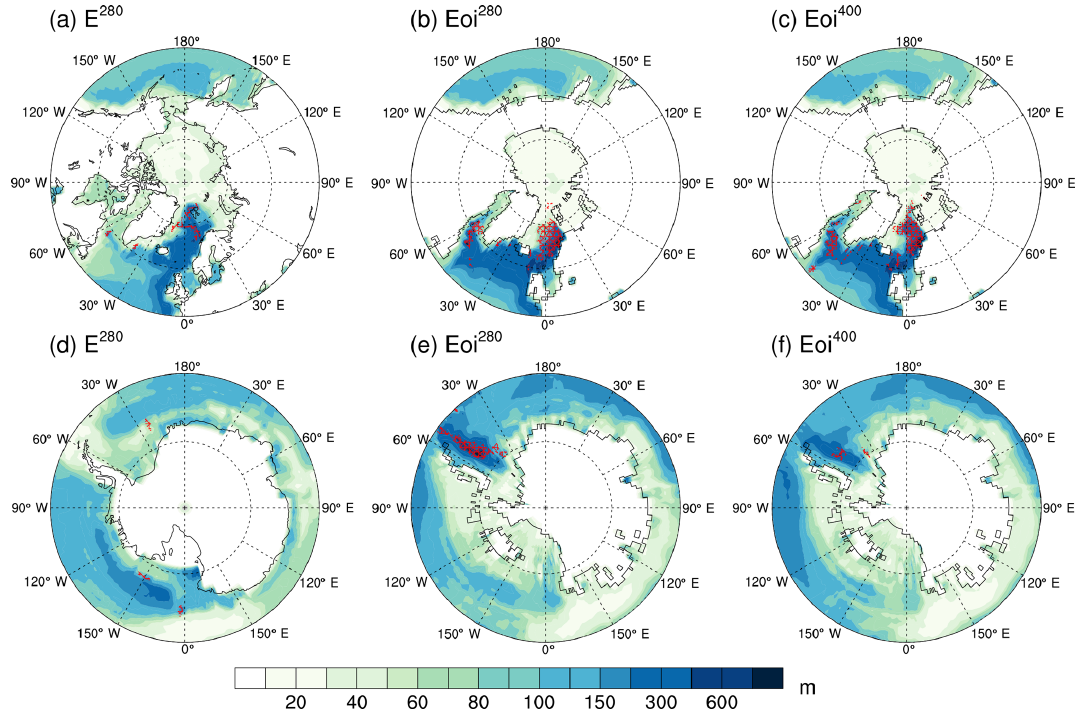
Figure 11. Mean March Northern Hemisphere and September Southern Hemisphere mixed layer depth for (a, d) E 280 , (b, e) Eoi 280 and (c, f) Eoi 400 . Red hashes indicate regions that exhibit deep ( > 1000m) convection at least 1 month during the climatological averaging period; single-cell ocean regions have been expanded slightly to improve visualisation.